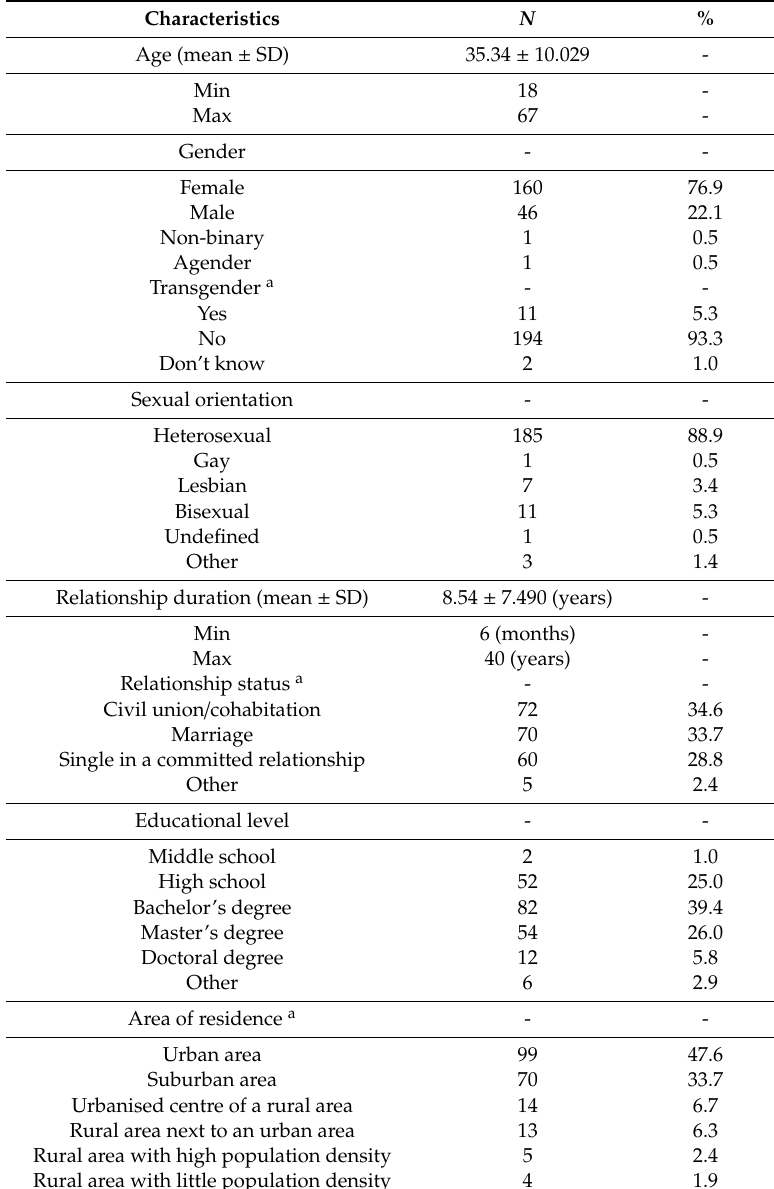
Table 1. Sociodemographic characteristics of participants ( n = 208).